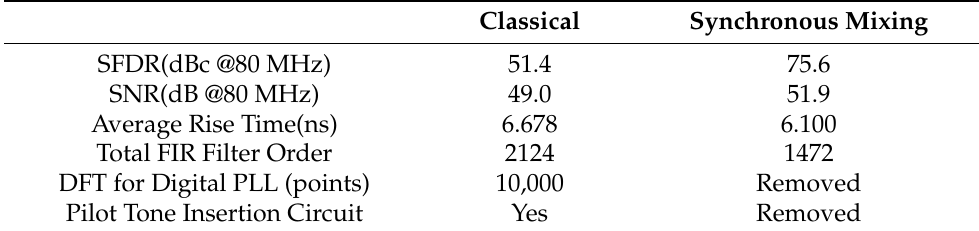
Table 4. Comparison of performance and cost between two